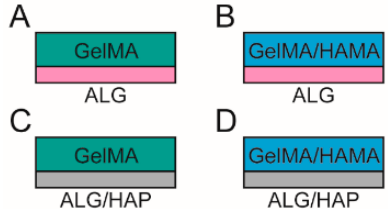
Figure 1. Schematic illustration of the groups included in the study.Groups used in the study comprised ( A ): gelatin methacrylamide (GelMA) with an alginate (ALG) paste scaffold; ( B ): GelMA with hyaluronic acid methacrylate (HAMA) with an ALG paste scaffold; ( C ): GelMA with a combined alginate and hydroxyapatite paste (ALG/HAP) scaffold; and ( D ): GelMA/HAMA with an ALG/HAP scaffold.